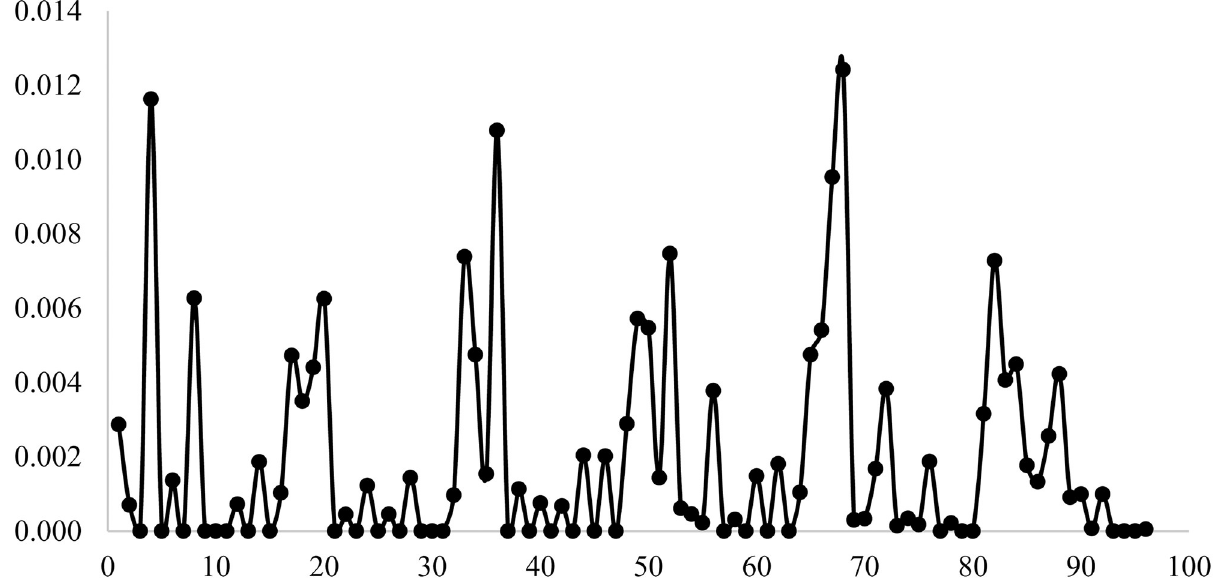
Fig 9. The variation of the average gap values when Tu changes for algorithm RLT .